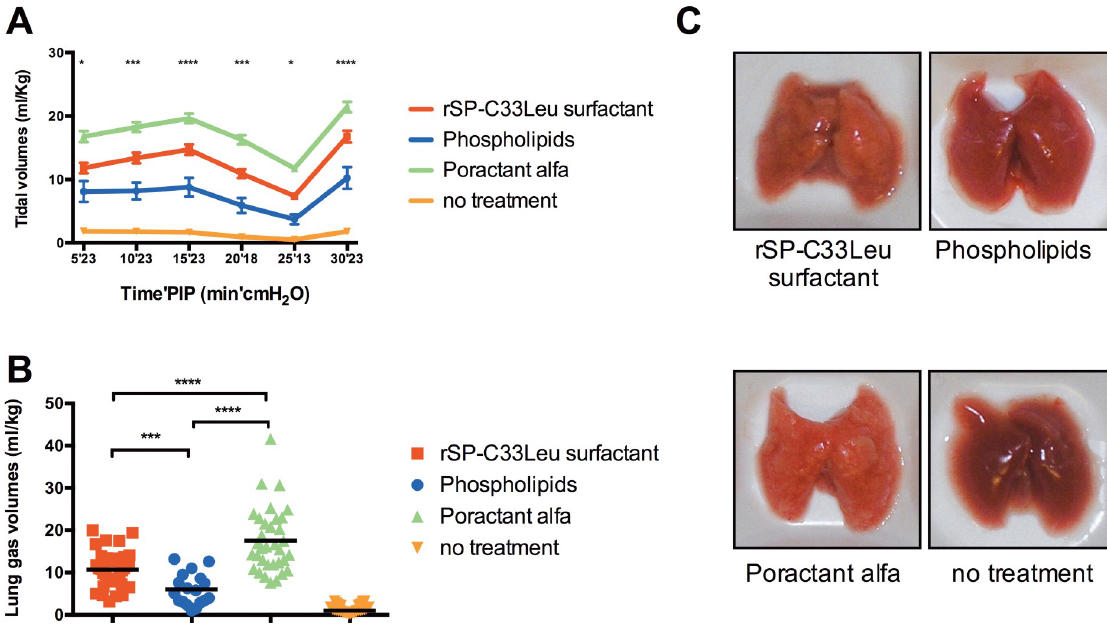
Fig 4. Effect of rSP-C33Leu surfactant on lung function and macroscopic appearance. (A) tidal volumes (V T ) during 30min ventilation of premature rabbit fetuses. Mean values and standard errors are shown. p-values between rSP-C33Leu surfactant and phospholipid treated groups are given according to: � = p � 0.05 and ��� = p � 0.001. (B) lung gas volumes (LGV) measured at the end of the ventilation period. Median LGV values are indicated by horizontal lines. ��� = p � 0.001 and ���� = p � 0.0001. (C) representative photographs of lungs of the animals in each treatment